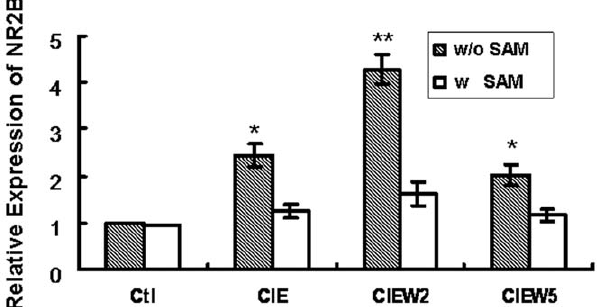
Figure 5. SAM prevents CIE-induced up-regulation of NR2B expression. The cortical neuronal cultures were treated by CIE regimen with and without the presence of SAM (2 mM). Total RNA was isolated and real time PCR for mRNA expression of NR2B was performed. Results are presented as the mean ratio to control 6 SEM; *, p , 0.05; **, p , 0.01 compared with their corresponding control